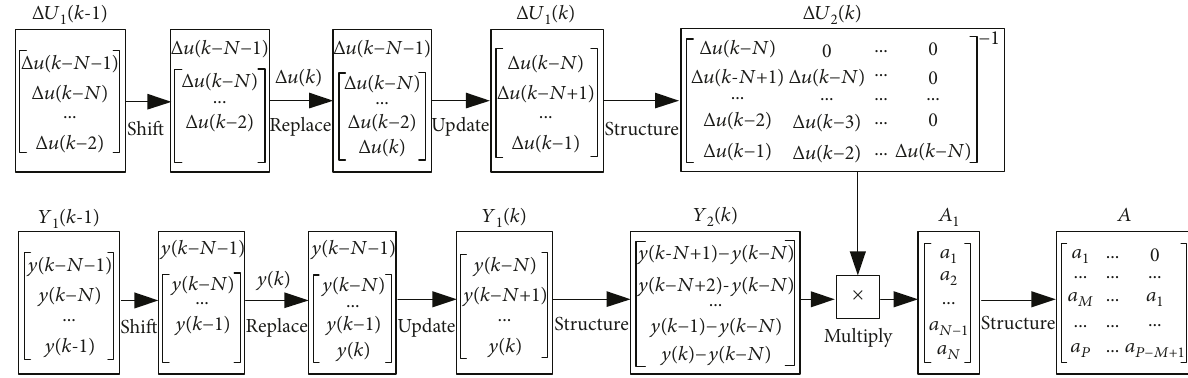
Figure 5: Flowchart of online identi fi cation